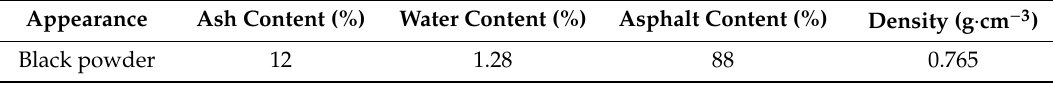
Table 3. Properties of UM native rock asphalt.